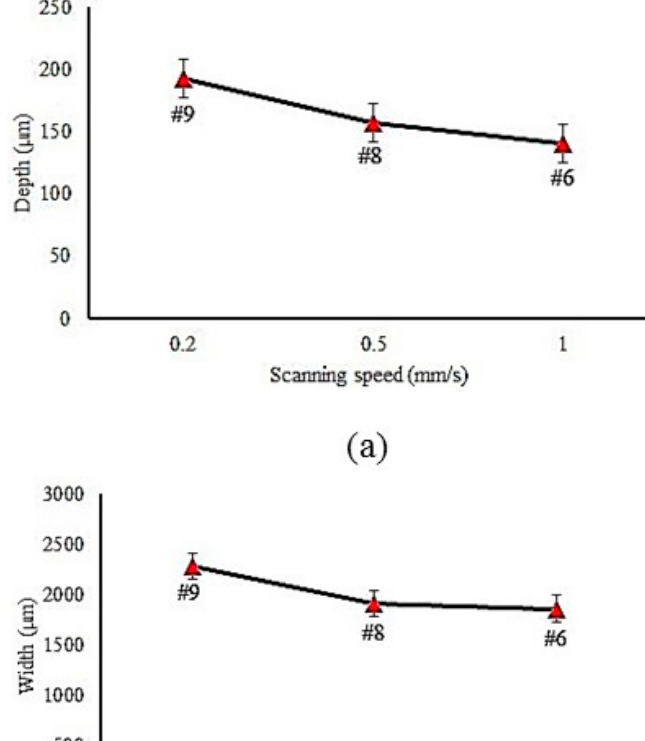
Figure 6. Influence of the focal plane position on LH (Laser Hardening Process) profile geometry. ( a ) Focal plane position on angle (samples #1, #2 and #3) ( b ) Focal plane position on width (samples #1, #2 and #3) ( c ) Focal plane position on depth (samples #1, #2 and #3).